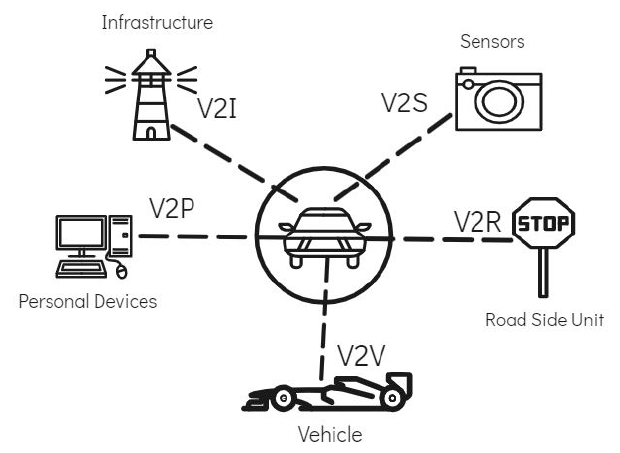
Figure 3. Epic wireless communication with the internet of vehicles.